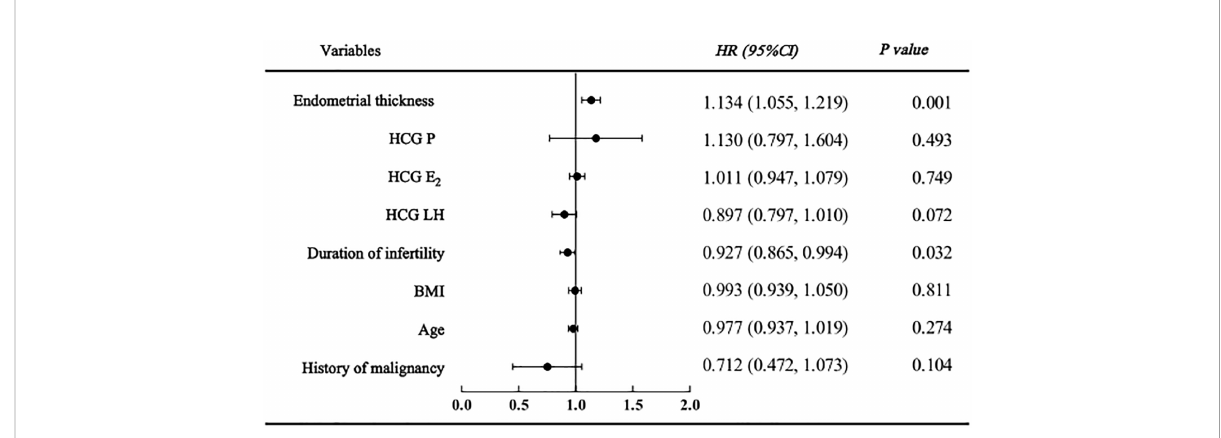
FIGURE 2 Cox regression analysis forest plot of clinical pregnancy affecting factors.